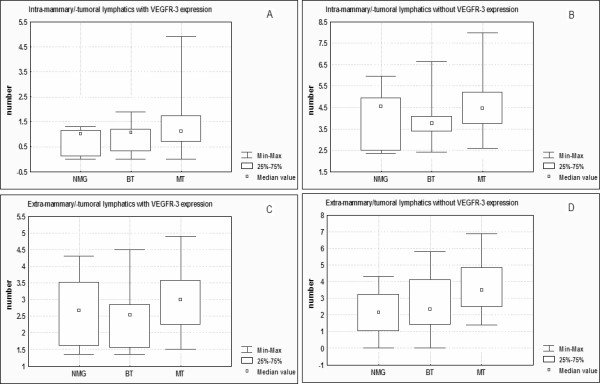
Number of lymphatics with and without VEGFR-3 expression in intramammary/intratumoral (A, B) and extramammary/extratumoral (C, D) fields in normal mammary gland (NMG), benign tumours (BT) and malignant tumours (MT).